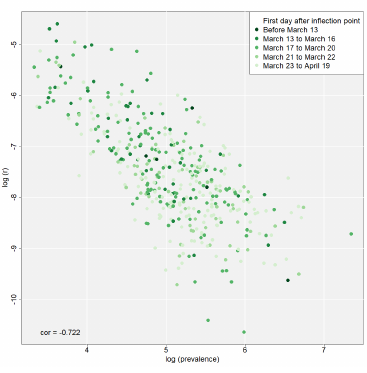
Figure 9: Growth rate and first day after inflection point vs.